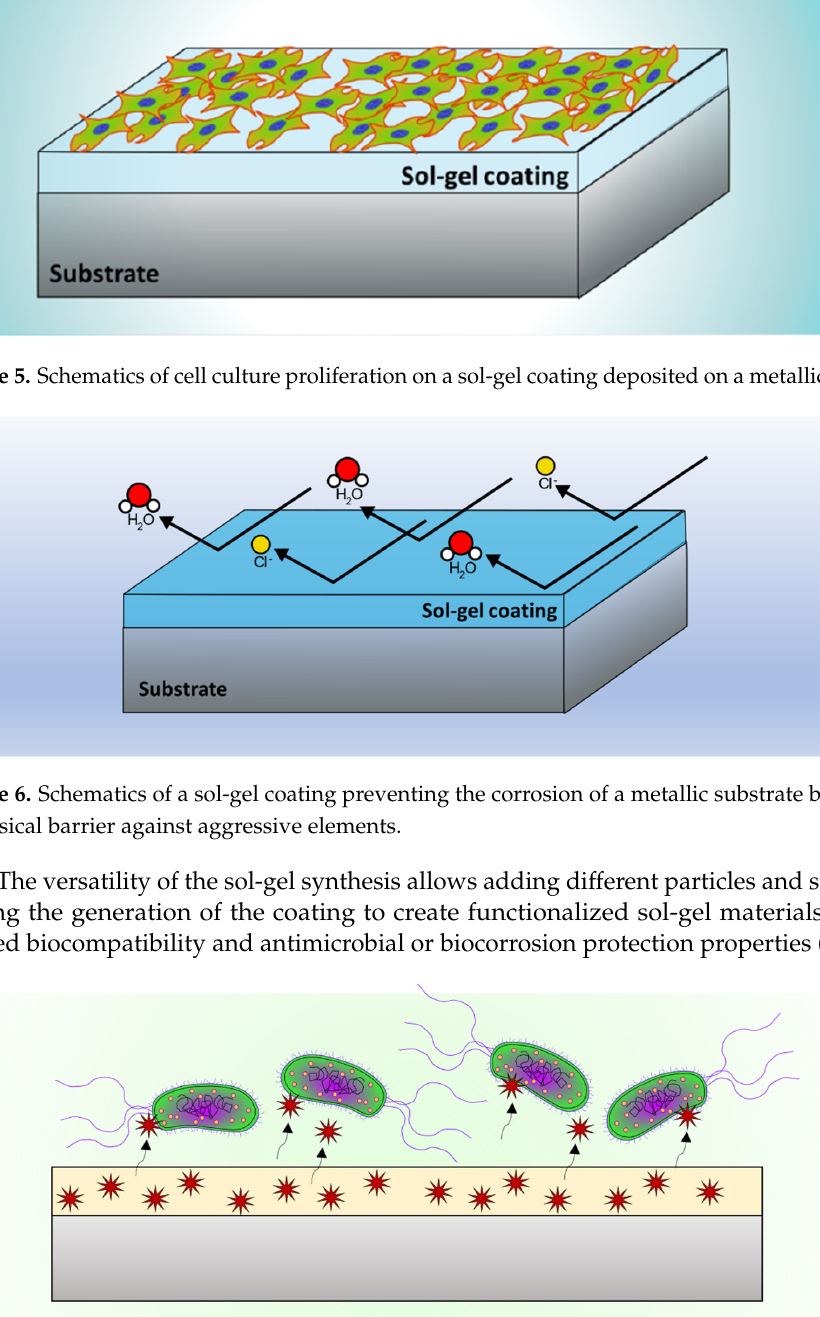
Figure 5. Schematics of cell culture proliferation on a sol-gel coating deposited on a metallic sub- strate.